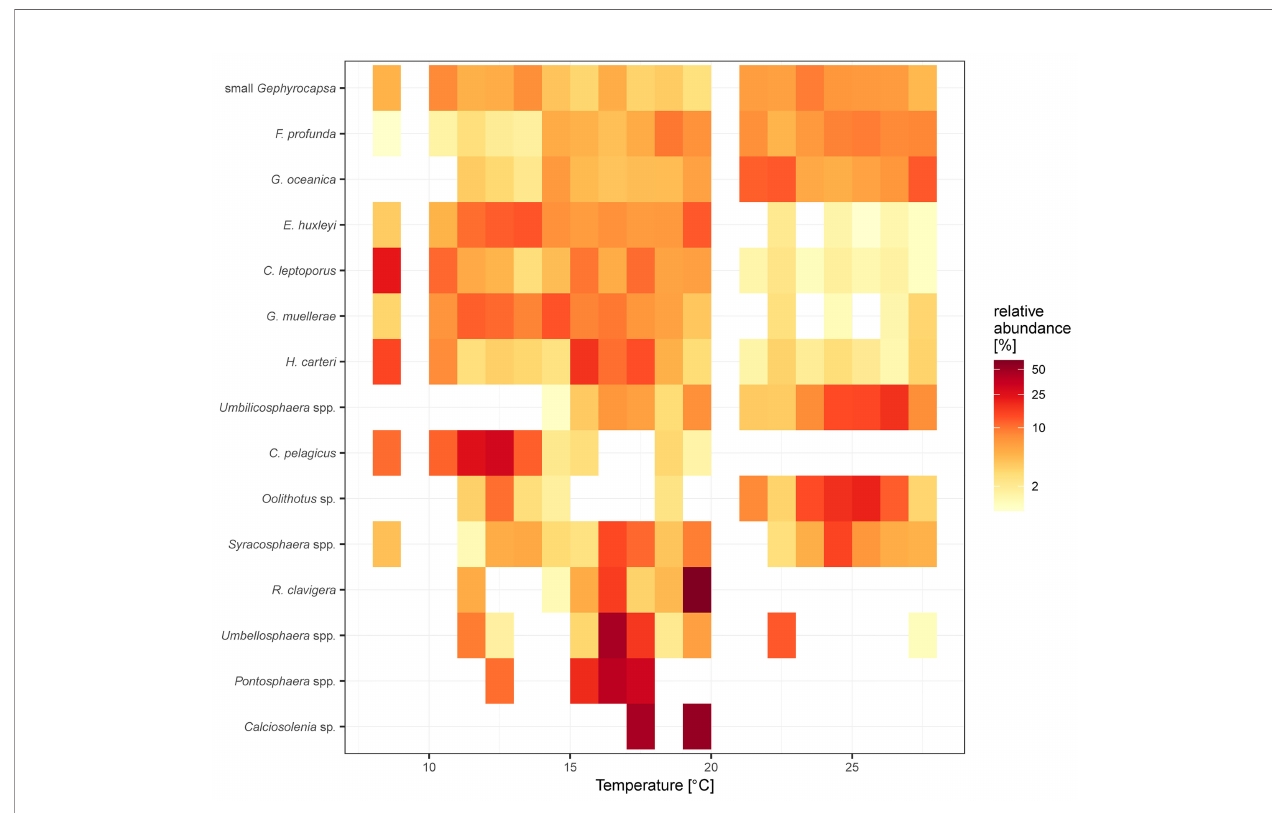
FIGURE 5 | Coccolithophore species thermal niche for surface sediment samples from Saavedra-Pellitero et al. (2010) and the present study. Colors indicate average relative abundance within 1°C bins. Note the gaps at 9-10°C and between 20-21°C, due to the lack of samples covering those speci fi c SSTa ranges.